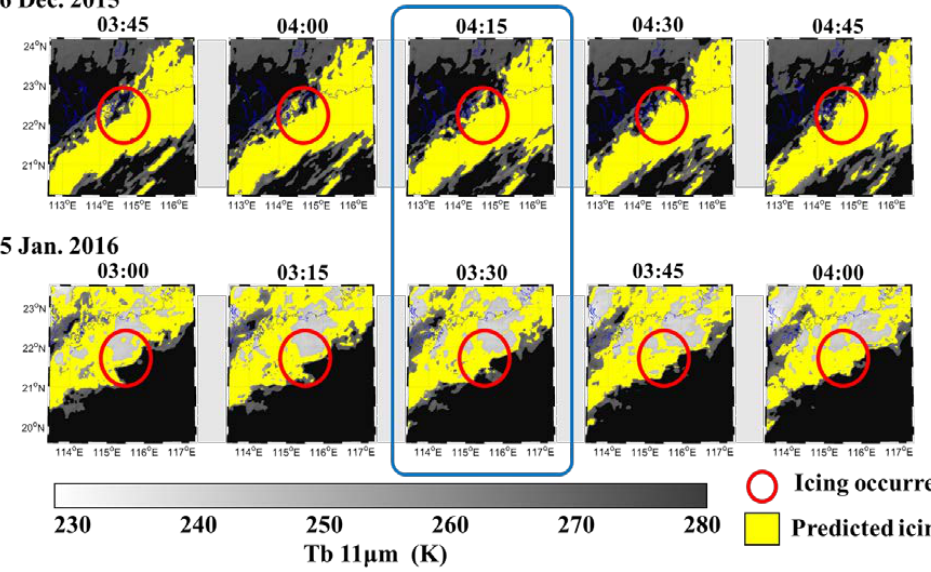
Figure 7. Time-series of potential icing areas when the COMS RF model was applied for two icing cases (i.e., the upper images on 6 December 2015 04:15 UTC with an icing pilot report (PIREP) at E22.19° and N114.60° and the bottom images on 5 January 2016 03:30 UTC with an icing PIREP at E21.58° and N115.41°). The corresponding 11 µm channel images were used as the background.